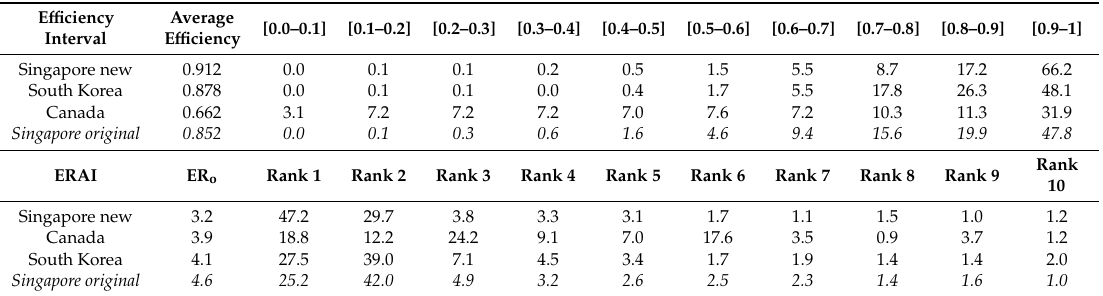
Table 13. Results for scenario 2. The EAIIs and the ERAIs are given in %. According to this scenario, Singapore has the best electricity supply resilience in the world. E ffi ciency